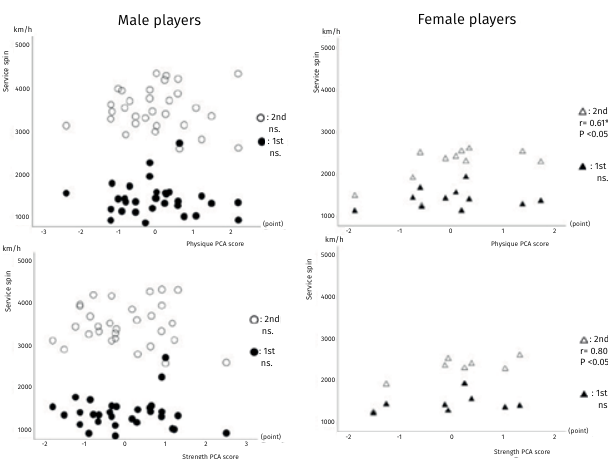
Figure 3. Correlation between service spin and physique PCA (upper row), and between service spin and physical strength PCA (bottom row) in male and female players. PCA: the first principal component analysis score.